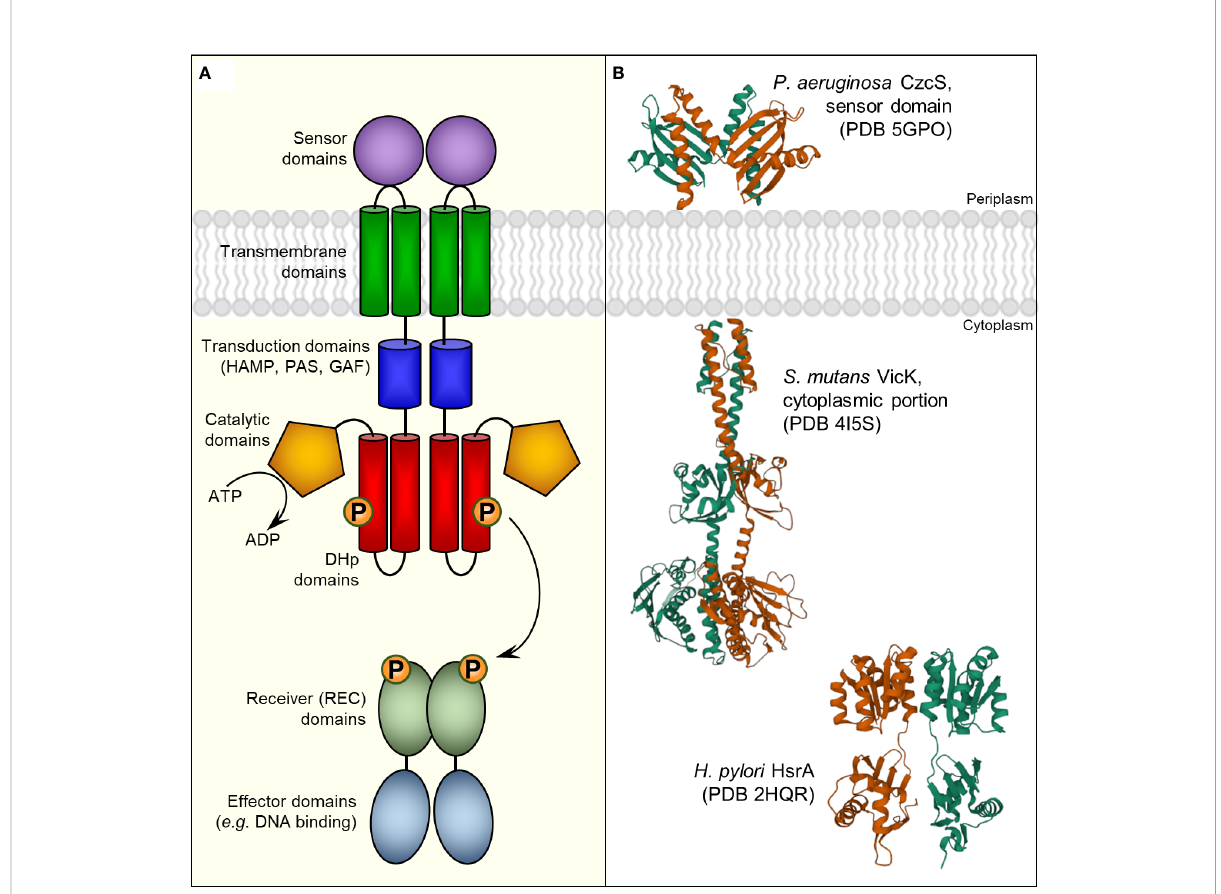
FIGURE 1 Bacterial two-component regulatory systems (TCRS). (A) Schematic representation of a typical TCRS comprising a membrane-anchored sensor histidine kinase (HK) and its cognate cytoplasmic response regulator (RR). Although microbial HKs can exhibit a considerable variety in their architectures (Jacob-Dubuisson et al., 2018), a canonical HK consists in a multi-domain homodimeric protein with extracellular sensors that perceives speci fi c stimuli and undergoes autophosphorylation in a conserved His residue through a cytosolic catalytic-ATP binding domain. Phosphoryl group is subsequently transferred to a conserved Asp residue of the cognate RR promoted mainly by intermolecular interactions between the dimerization and histidine phosphotransfer (DHp) domains of the HK and the receiver (REC) domain of the RR (Yamada et al., 2009). Thus, the speci fi city of the interaction between a given HK and its cognate RR appears to be primarily de fi ned by the nature and positions of contacting residues at the interface between the DHp (HK) and the REC (RR) domains, though additional HK domains could also be involved in RR binding (Buschiazzo and Trajtenberg, 2019). (B) 3D structures of different HK- and RR-functional domains. Corresponding Protein Data Bank (PDB) entries appear in